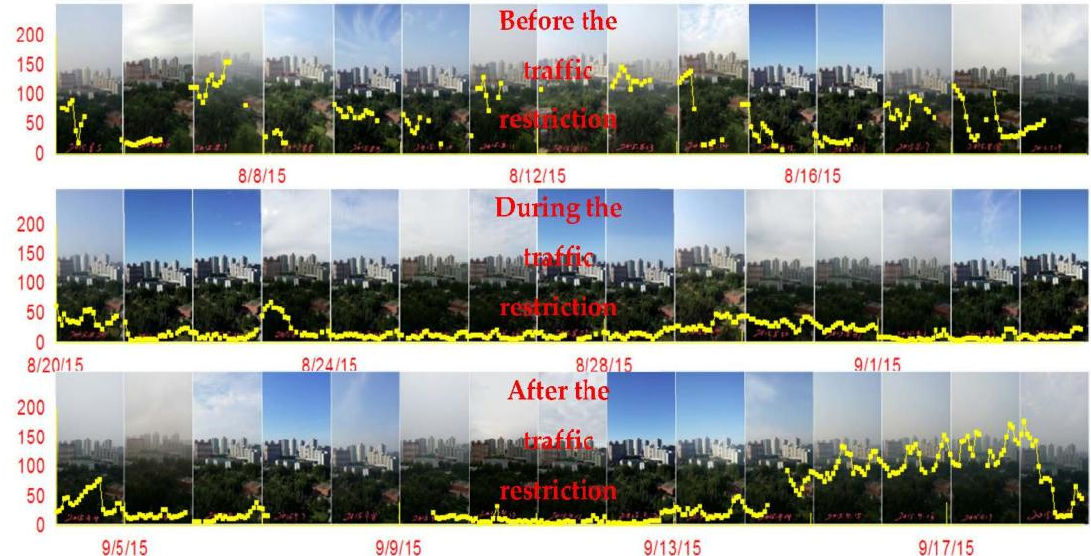
Figure 2. Hourly concentration of PM 2.5 in Monitoring sites of Beijing Olympic Sports Center. Notes: The yellow line represents the trends of hourly concentration of PM 2.5 when before, during, and after the restriction (from 5 August to 19 September). The y -axis is the concentration of PM 2.5 , among the unit is µ g · m − 3 . The x -axis is the date when from 5 August to 19 September. The picture shows the daily weather conditions at 07:00 of the monitoring site from 5 August to 19 September.